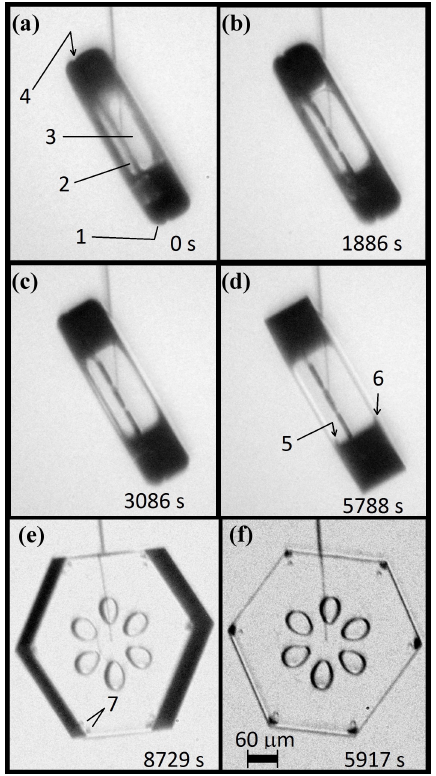
Figure 3. Corner-pocket formation at − 29 ◦ C after sublimation rounding. (a) Side view of crystal at end of sublimation run. Marked point 1 shows a rounded basal–prism corner; 2, side view of interior planar air pockets; 3, view through two prism faces showing curved bounding edges (evidence from lack of sharpness); and 4, a perime- ter groove bounding the same interior basal plane as the interior air pockets. (b) – (e) Subsequent sharpening of the basal–prism corner under growth conditions. Marked points 5 and 6 appear to show side views of the corner pockets. (e) The basal face partly turned into view, showing a corner-pocket pair near each prism–prism edge at 7. (f) Front view showing the 12 corner pockets (two pockets per prism–prism edge, each pocket near opposing basal faces). Line coming down from the top is the capillary, terminating in the crystal at the nucleation point. Supersaturation was constant at about